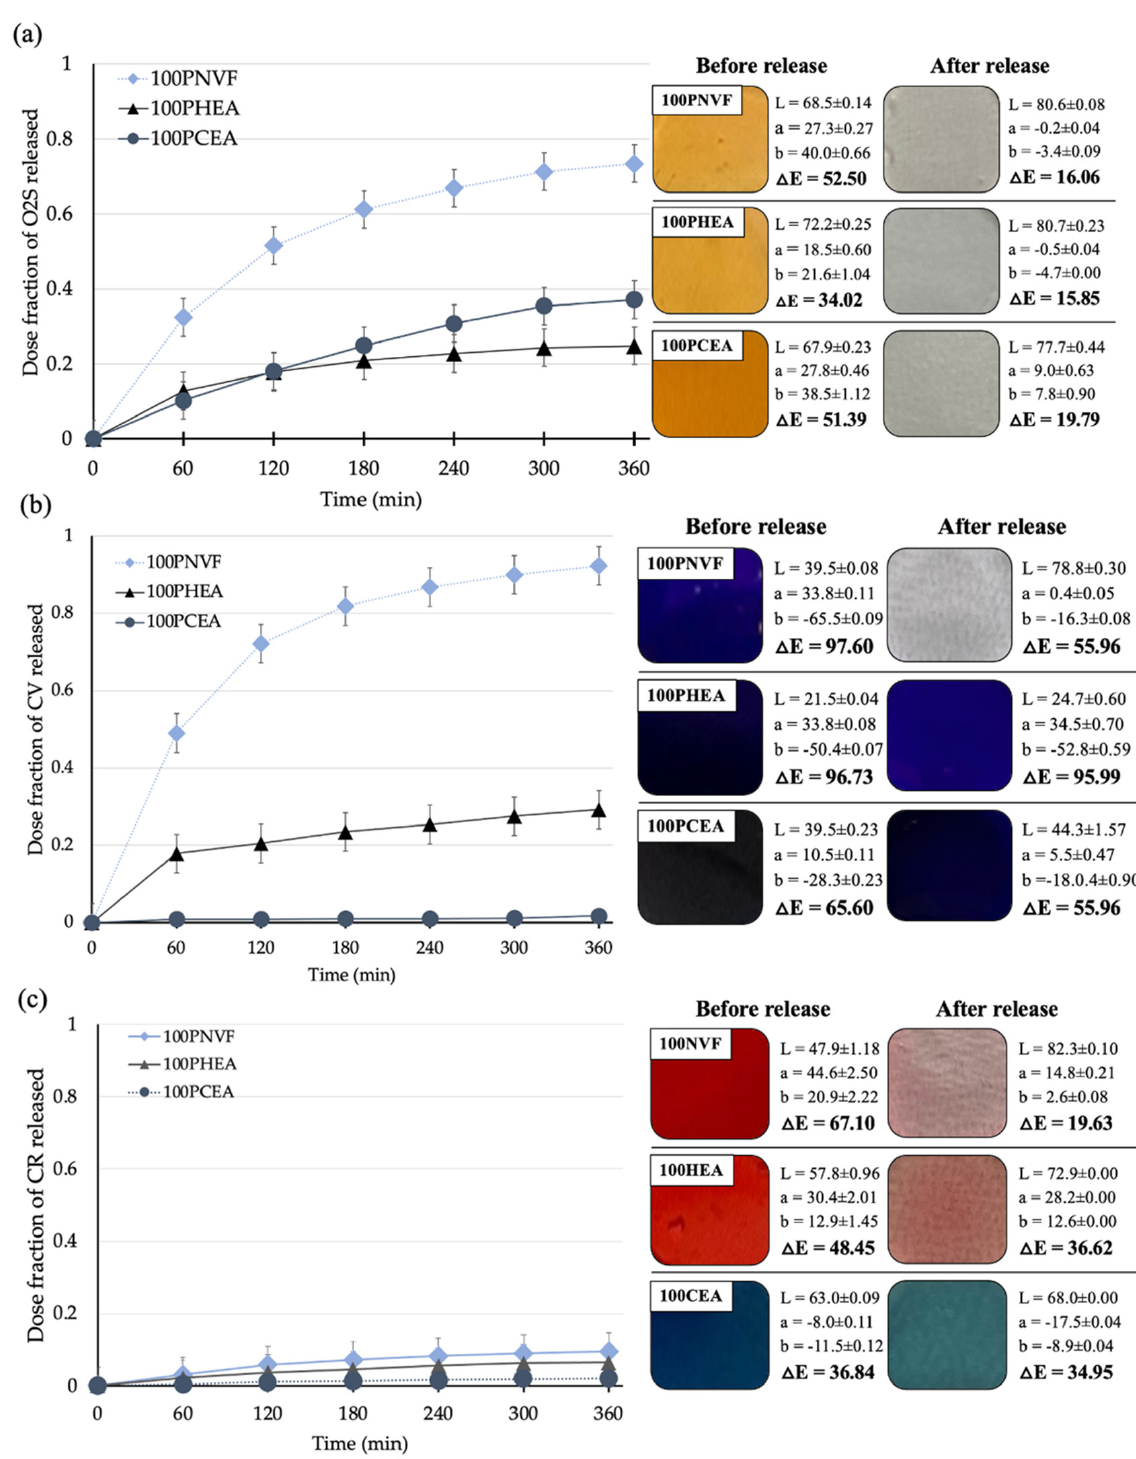
Figure 5. Dye release profiles of homopolymer—100PNVF, 100PHEA, and 100PCEA ( left ) and visual color and total color difference parameters of hydrogels ( right ) before and after dye release: ( a ) orange II sodium salt, ( b ) crystal violet, and ( c ) Congo red.